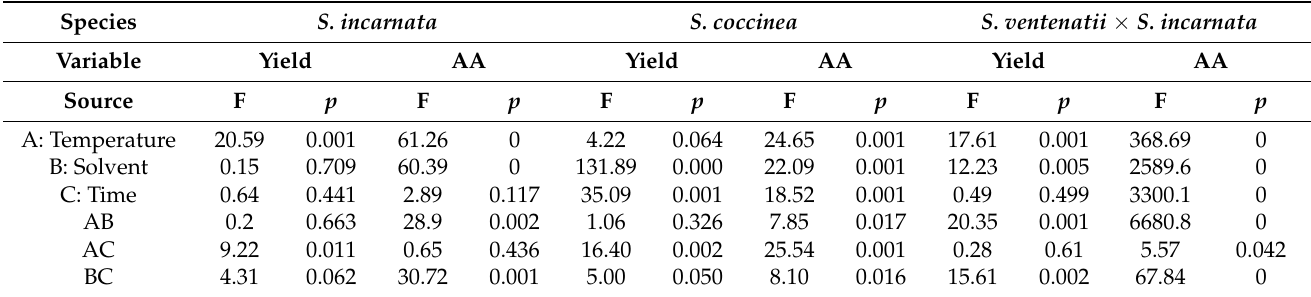
Table 1. Results of the analysis of variance used to evaluate the effect of the extraction conditions on the yield and antioxidant activity of hydroalcoholic extracts obtained from S . incarnata , S . coccinea and S . ventenatii × S . incarnata dried plants.